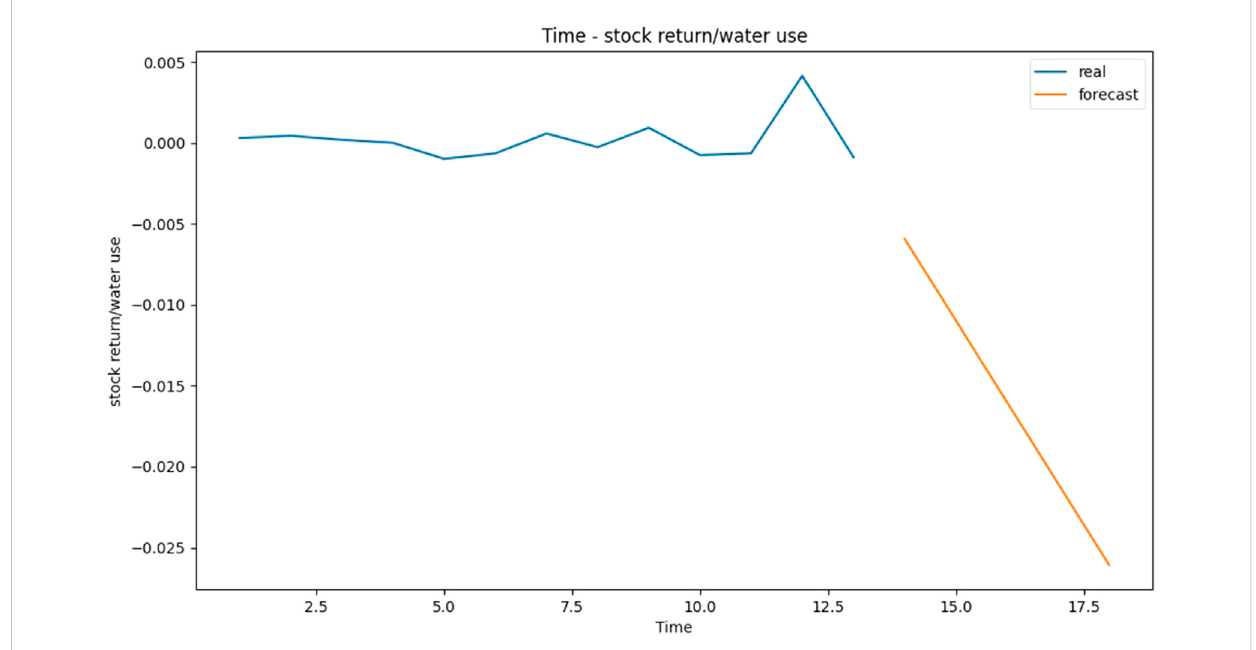
FIGURE 1 Forecast results in China.